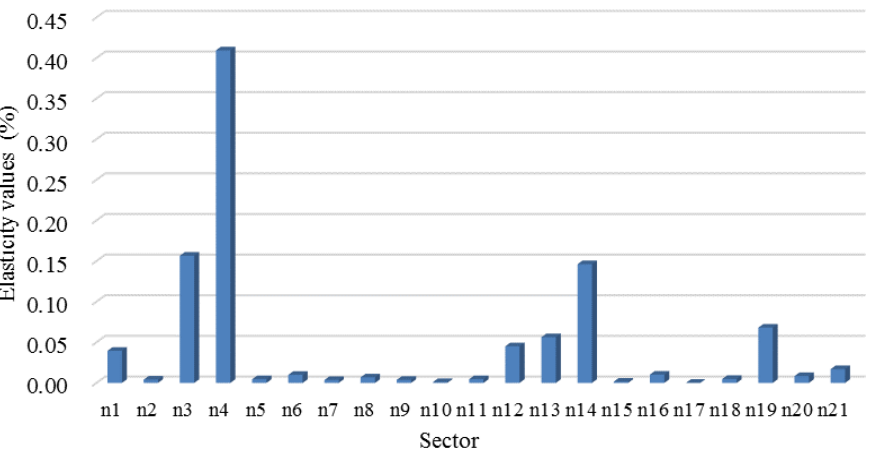
Figure 3. Elasticity values for direct-emission coefficient ( C ) based on sensitivity analysis. The notations n1–n21 are the abbreviations for China’s 21 sectors, with the detailed descriptions presented in Table 3.